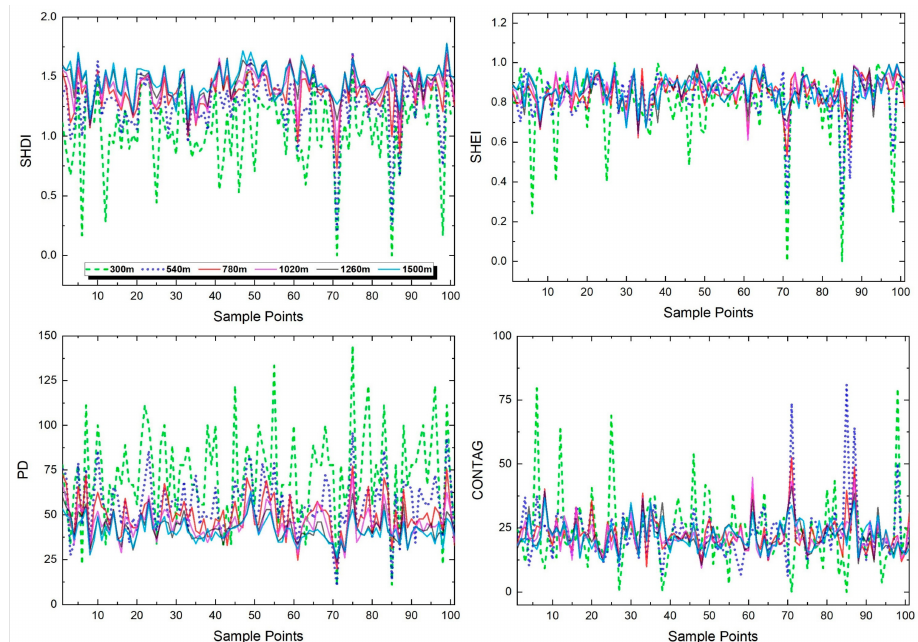
Figure A2. Trends in the variation of landscape − level metrics of 101 sample points for different spatial extents.